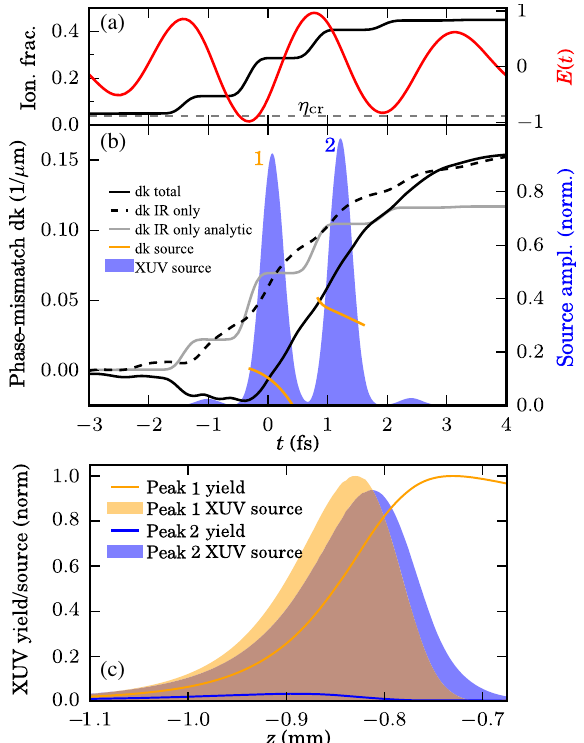
FIG. 3. On-axis transient phase-matching and XUV generation in argon. (a) Driving laser pulse (red) and the time-dependent fraction of ionized atoms (black). (b) On-axis phase mismatch in the analytic expression without a dipole (gray), the calculated phase mismatch with the dipole contribution (black) and without (black dashed), and the numerical phase mismatch calculated from the complex source term (orange) and the source-term amplitude (blue shaded area) at z ¼ − 0 . 8 mm. (c) On-axis source-term amplitude (shaded area) and evolution of the XUV amplitude from the full simulation (solid line). The color indicates the first (orange) or second (blue) half-cycle centered around 0.1 fs and 1.2 fs, respectively, as shown in panel